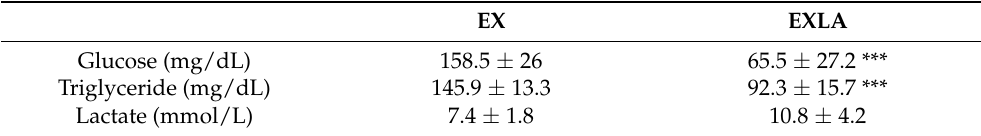
Table 1. Whole blood glucose, triglyceride, and lactate